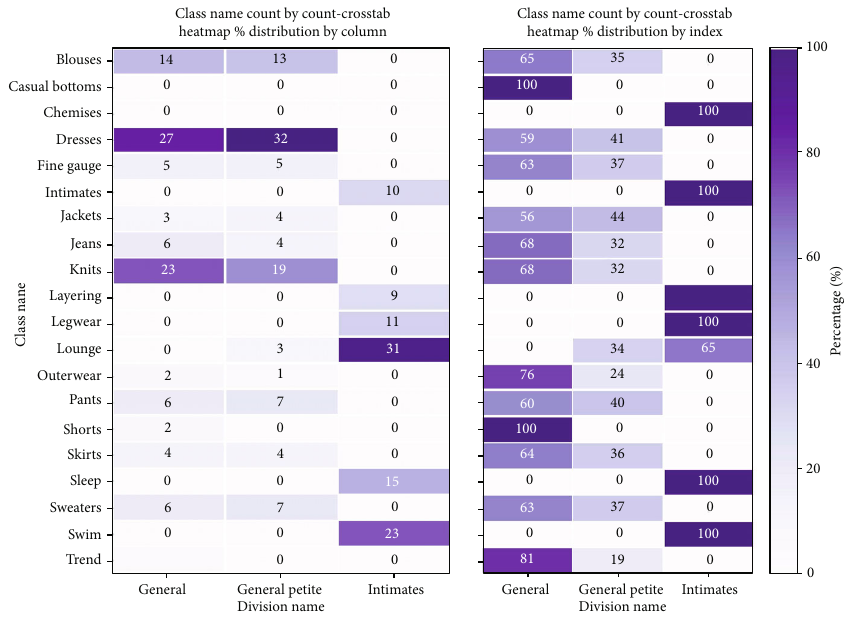
Figure 12: The most reviewed clothing are from a standard petite size.